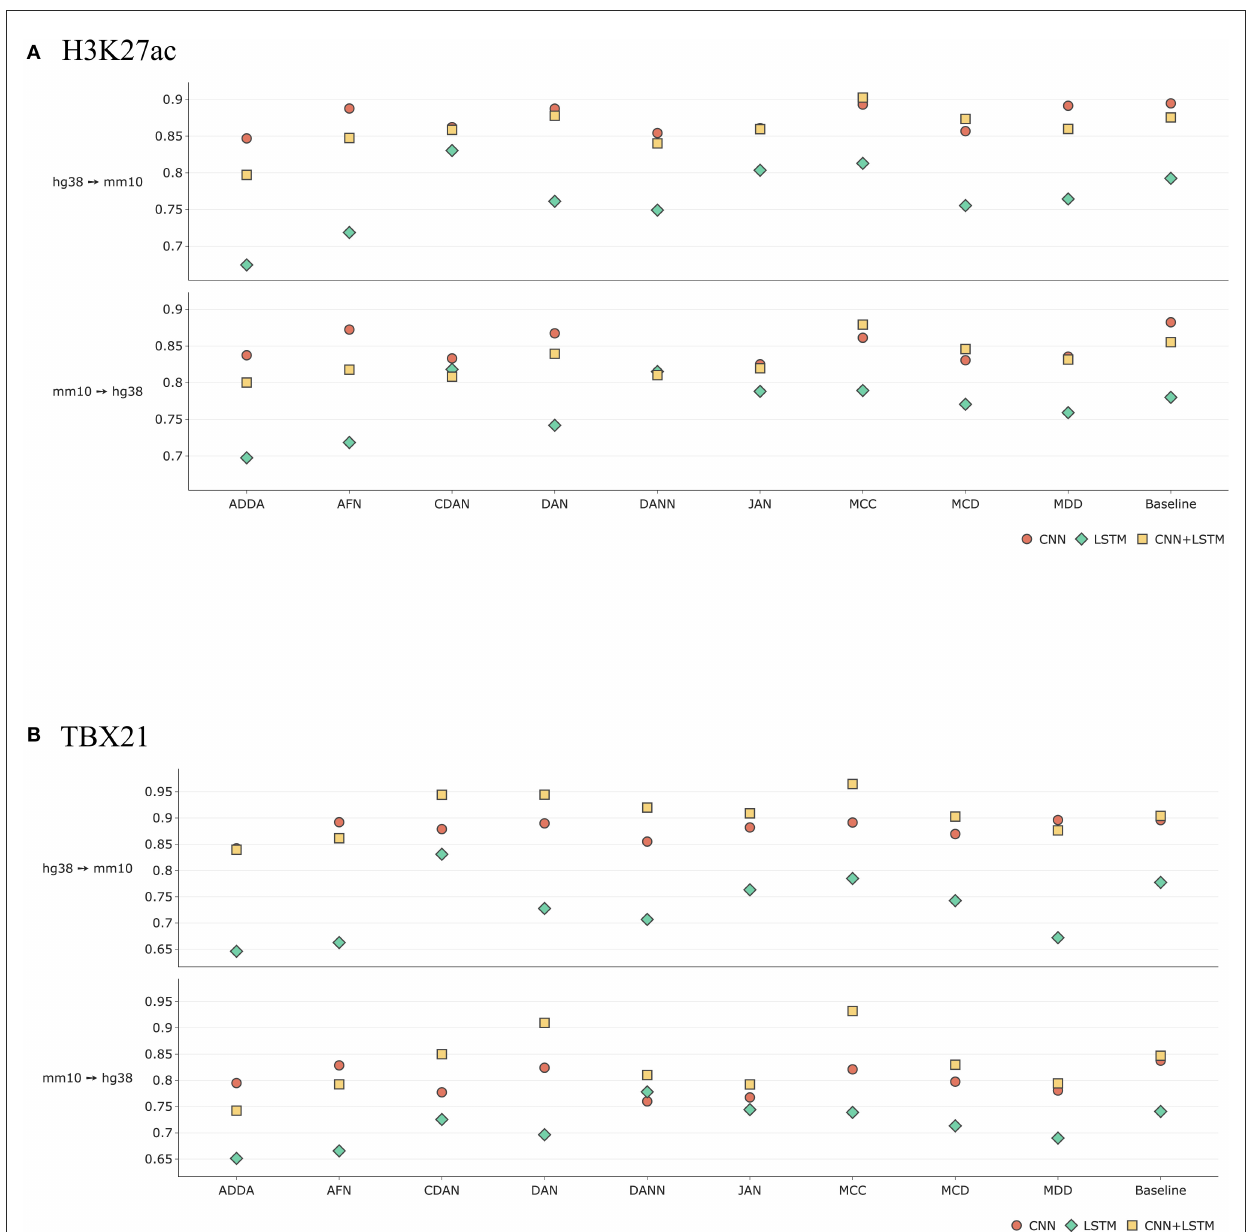
FIGURE8 Comparative performance (ROC AUC) of Domain Adaptation methods with different baseline DL models—CNN-only, LSTM-only, and CNN + LSTM for (A) H3K27ac histone mark and the (B) TBX21 transcription factor (see comparison based on PR AUC and accuracy in Supplementary Figure 7). Y axis depicts absolute values of ROC AUC for each model. Overall, taking together ROC AUC, RP AUC, and accuracy, hybrid CNN + LSTM model outperforms CNN and LSTM models for transcription factor TBX21, and CNN outperforms CNN + LSTM for histone mark H3K27ac. When performing transfer for a particular experiment, one can make a choice between DL types based on performance of baseline